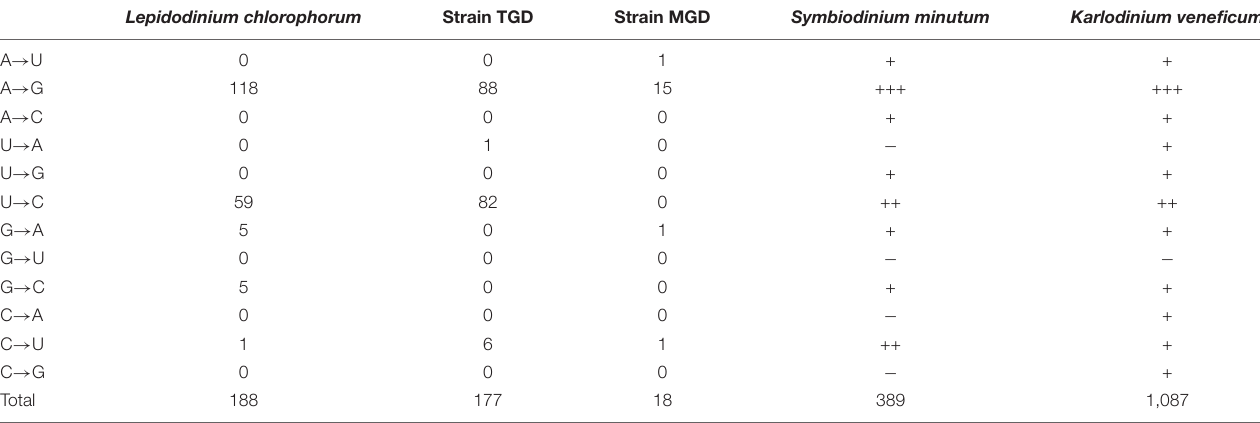
TABLE 2 | Patterns of base-conversion editing in the plastid gene transcripts of the three peDinoflagellates, Symbiodinium minutum , and Karlodinium veneficum . Lepidodinium chlorophorum Strain TGD Strain MGD Symbiodinium minutum